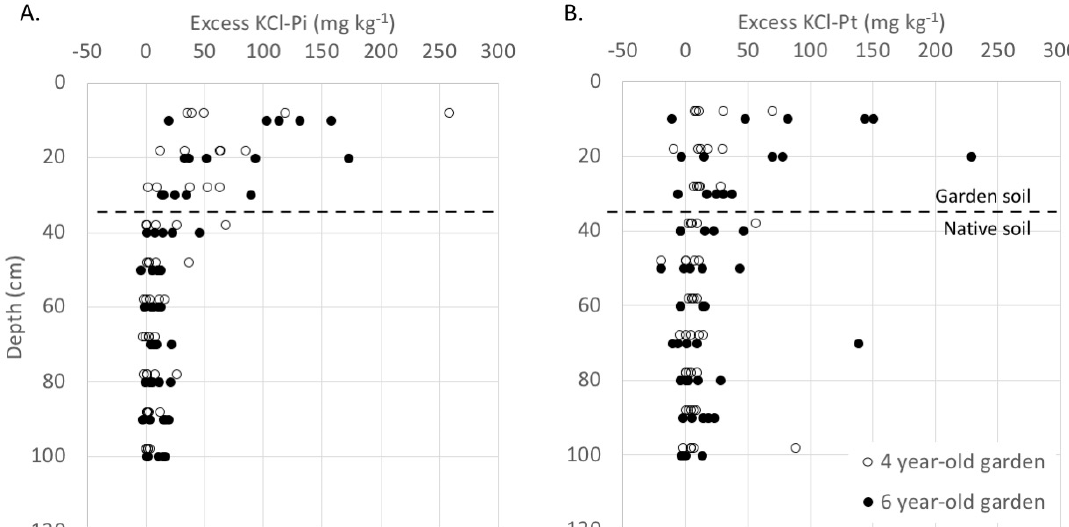
Figure 1. ( a ) Excess KCl-P i (garden plot–reference plot) by depth for soil below garden plots of 4 years (open circles) and 6 years (closed circles). Symbols are slightly o ff set on Y-axis for legibility. ( b ) Excess KCl-P t (garden plot–reference plot) by depth for soil below garden plots of 4 years and 6 years. Table 2. Parameter estimates for log 10 -transformed excess KCl-P i (garden plot–control plot) in the top 70 cm of native soil below raised-bed gardens, as a function of garden age, soil depth, and garden age × soil depth.